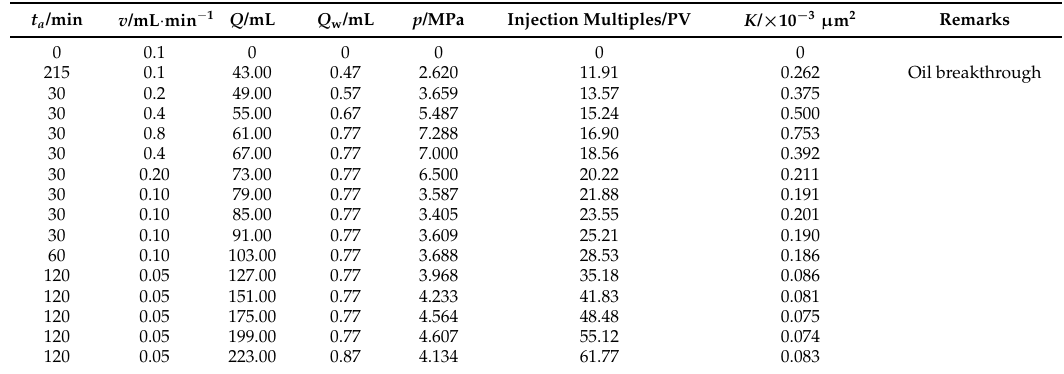
Table 7. Saturated oil again experimental